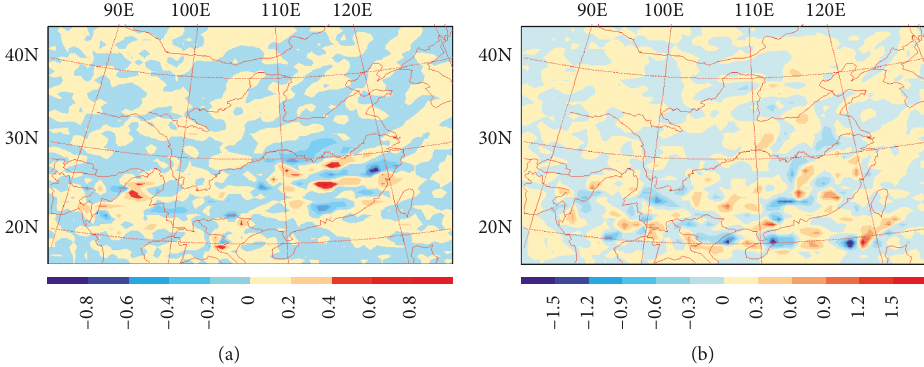
Figure 13: Distributions of the changes of precipitation (mm/d) caused by BC aerosols in China. (a) Summer. (b)